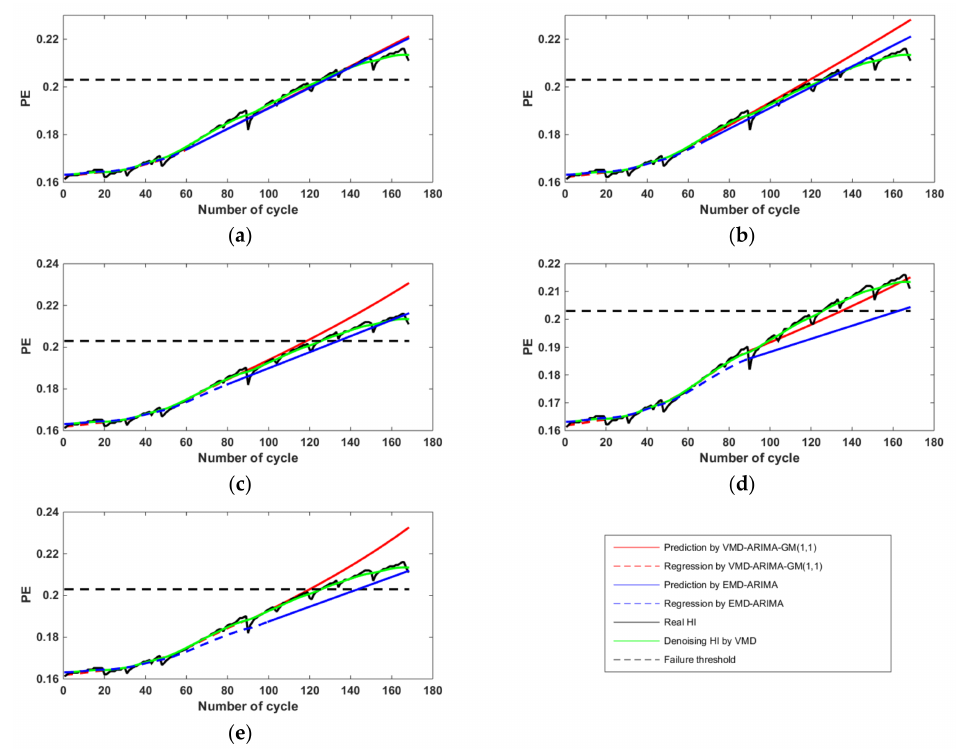
Figure 7. RUL prediction for battery No. 5 at ( a ) 60 cycles; ( b ) 70 cycles; ( c ) 80 cycles; ( d ) 90 cycles; ( e ) 100 cycles.